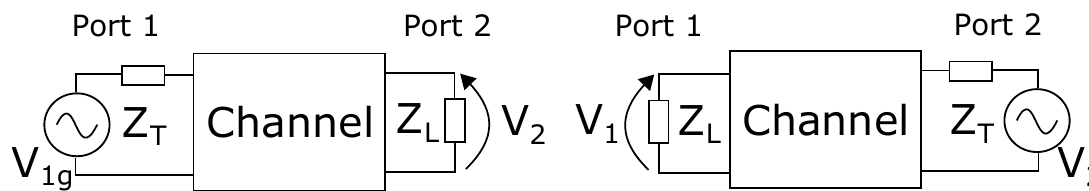
Figure 2. Traditional communication scheme, with the generator either on Port 1 or on Port